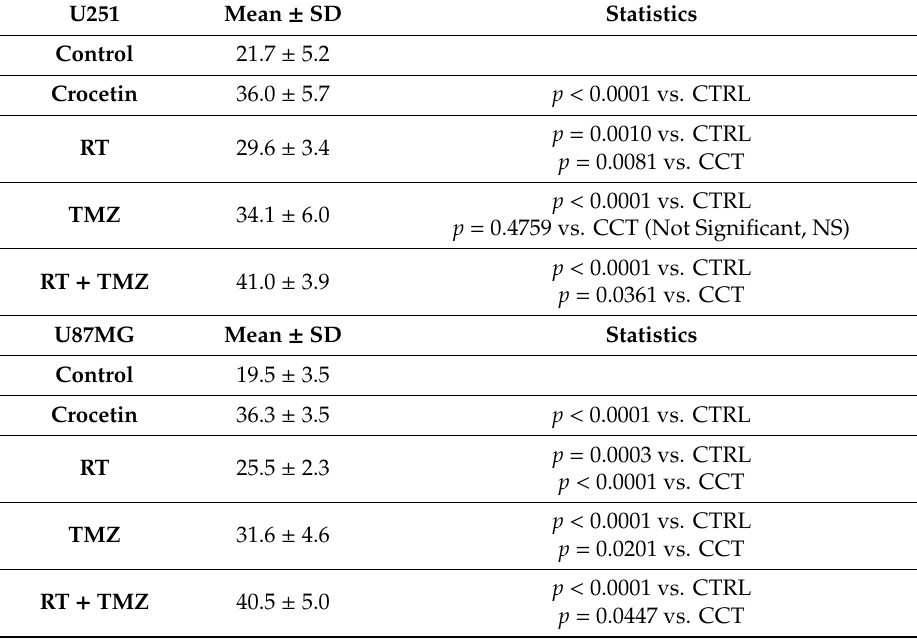
Figure 4. In vivo studies. Crocetin modifies tumor growth of GBM cells subcutaneously injected into female nu / nu mice (subcutaneous xenograft model). U251 and U87MG xenografts were treated with CCT (100 mg / kg / day per os), temozolomide (16 mg / kg for 5 consecutive days), RT (single dose of 4 Gy administered at day 5) and combination RT + TMZ (standard of care). ( A ) Time of tumor progression (TTP) calculated from the U251 xenograft. ( B ) Kaplan–Meier graphical analyses. ( C ) Time of tumor progression (TTP) calculated from the U87MG xenograft. ( D ) Kaplan–Meier graphical analyses. Table 2. Summarized statistical data from the TTP analysis, as seen in Figure